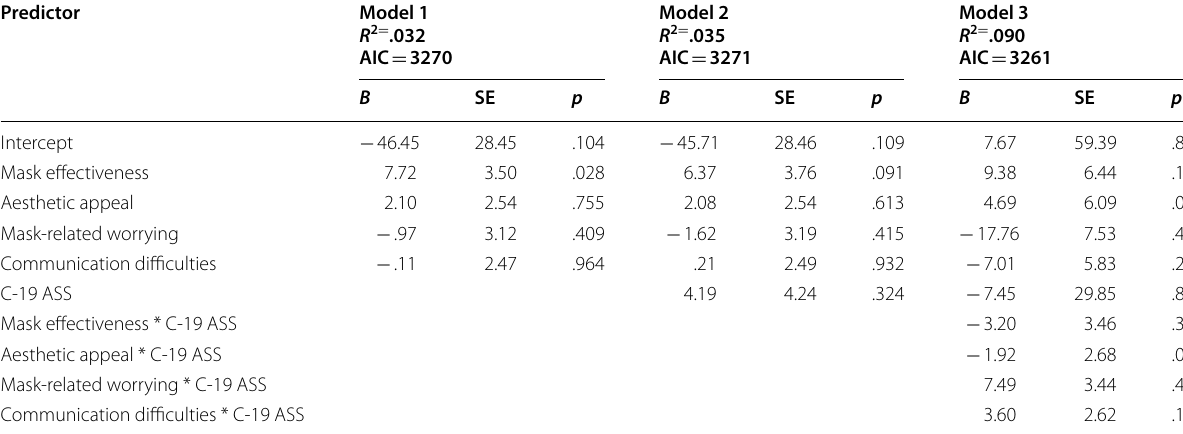
Covid 19 Anxiety Syndrome Scale scores ranged from 0 to 4. Mask effectiveness, aesthetic appeal, mask-related worrying, and communication difficulties scores ranged from 1 to 7